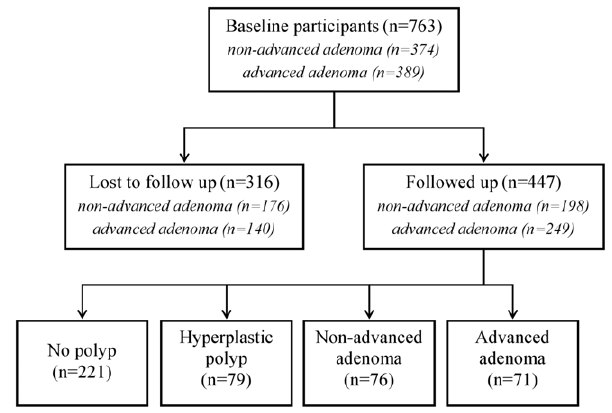
Figure 2. Flow diagram for the colorectal adenoma recurrence